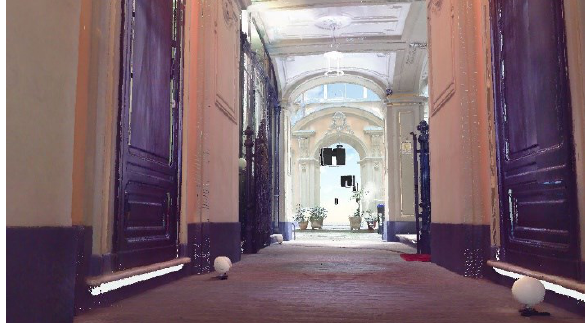
Figure 8. Location of spheres and scan points. Image extracted from the point cloud. Scanning: M. C. López González.